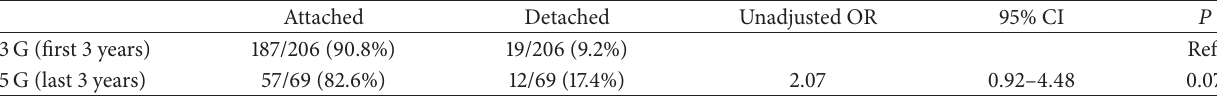
Table 7: Comparison between 23 G group (first 3 years) and 25 G group (last 3